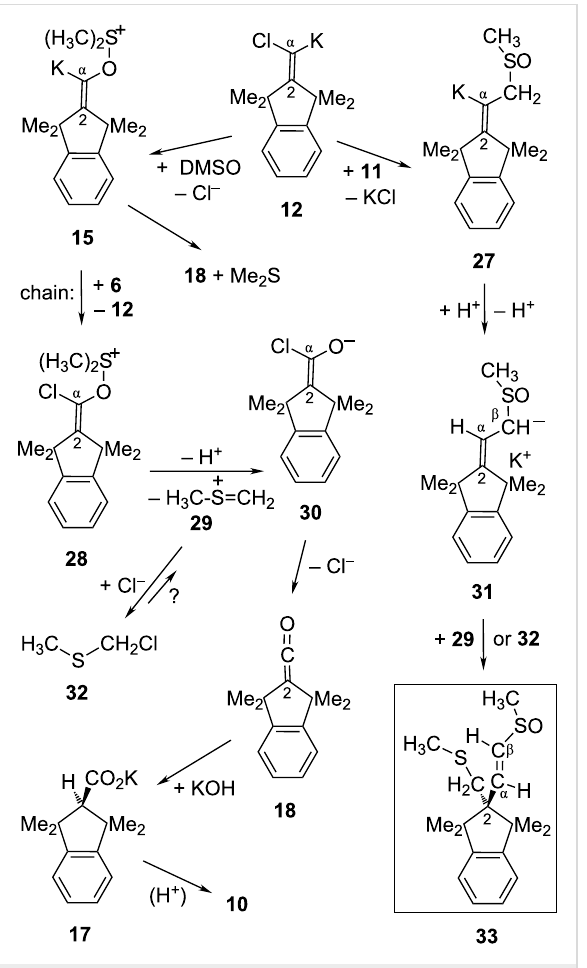
Scheme 5: Possible course of the carbenoid chain reaction of 12 with DMSO and the α , α -dichloroalkene 6 .